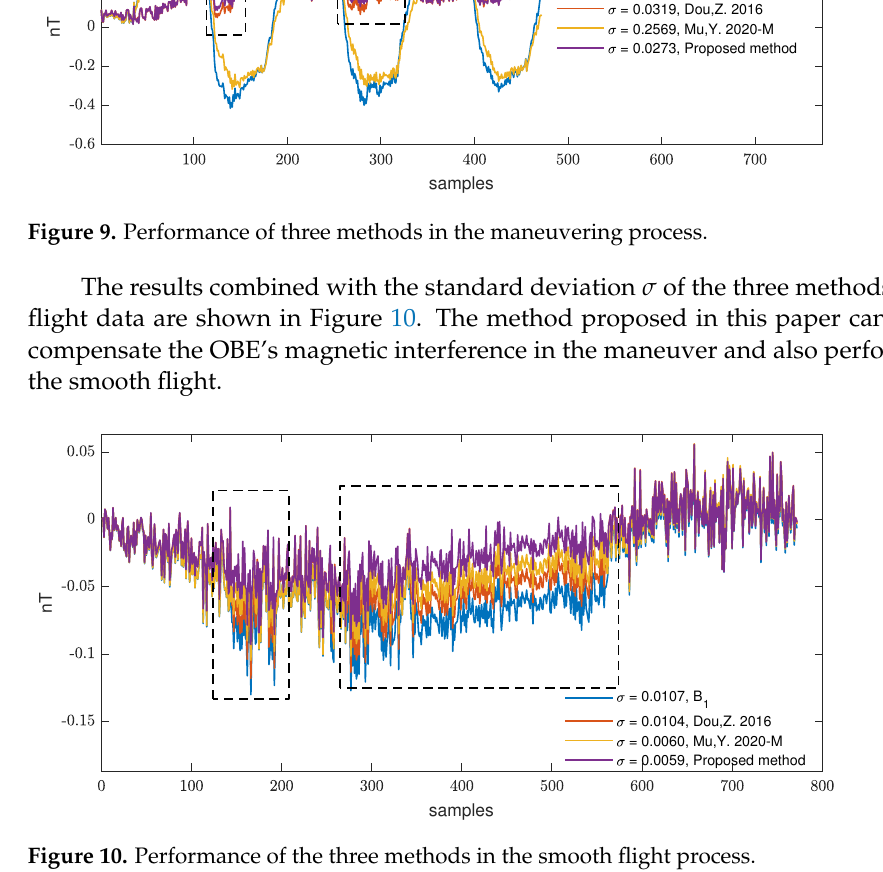
Figure 10. Performance of the three methods in the smooth flight